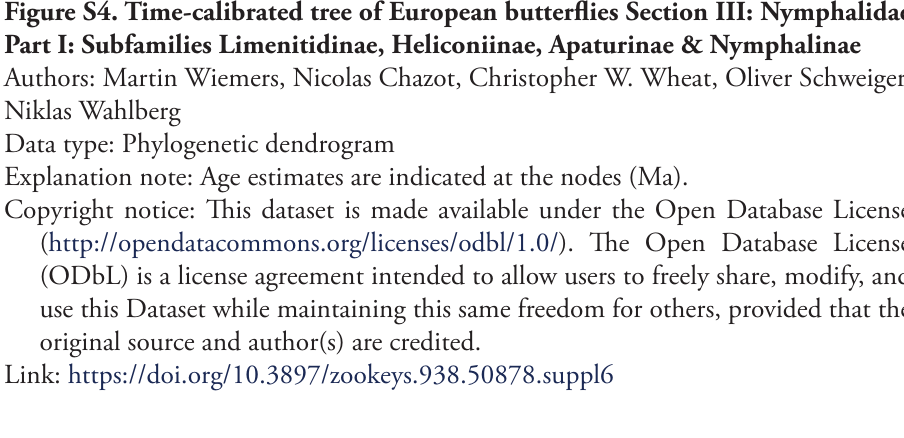
Figure S4. Time-calibrated tree of European butterflies Section III: Nymphalidae Part I: Subfamilies Limenitidinae, Helico niinae, Apaturinae &